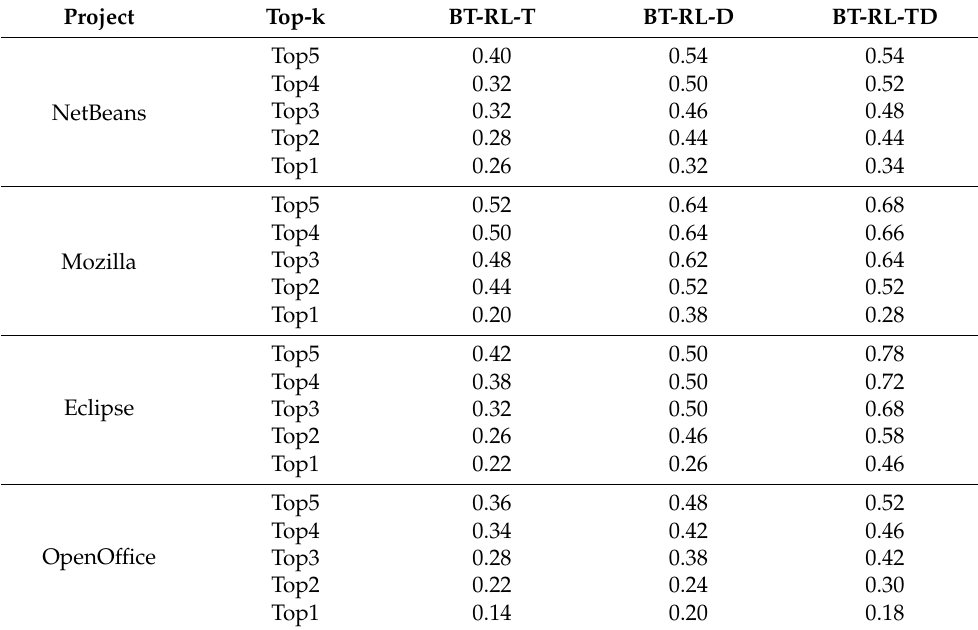
Table 6. The accuracy of BT-RL considering different